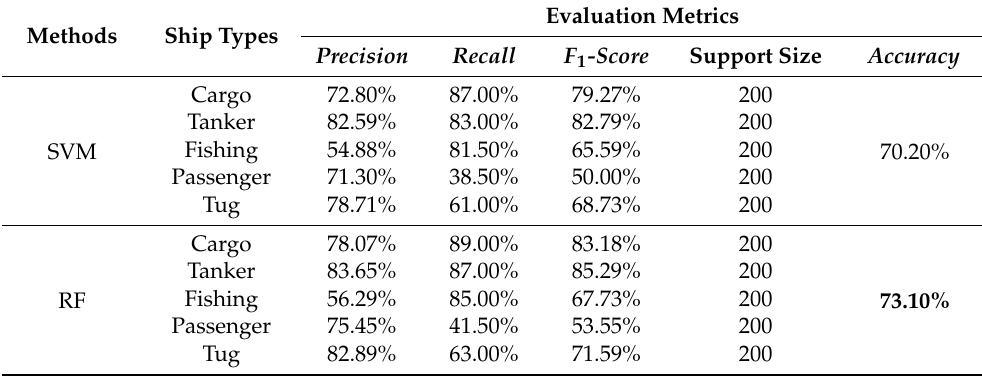
Table 5. The classification results of the five types of ships considering the geometric features.